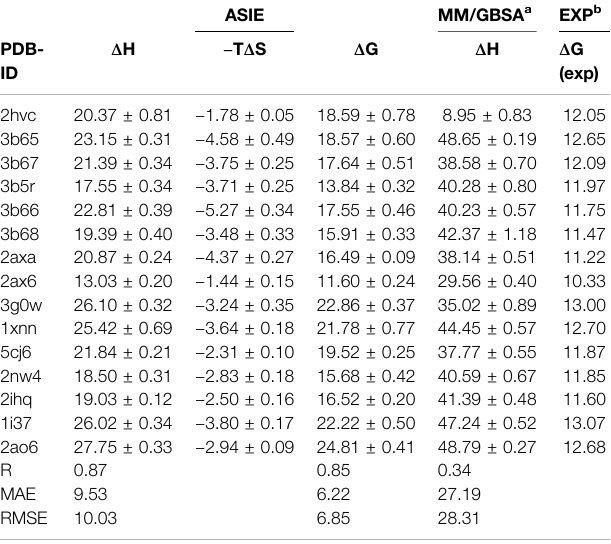
TABLE 4| Binding FreeEnergies(kcal/mol)calculatedbyASIEmethodcompared to the experimental data (kcal/mol).